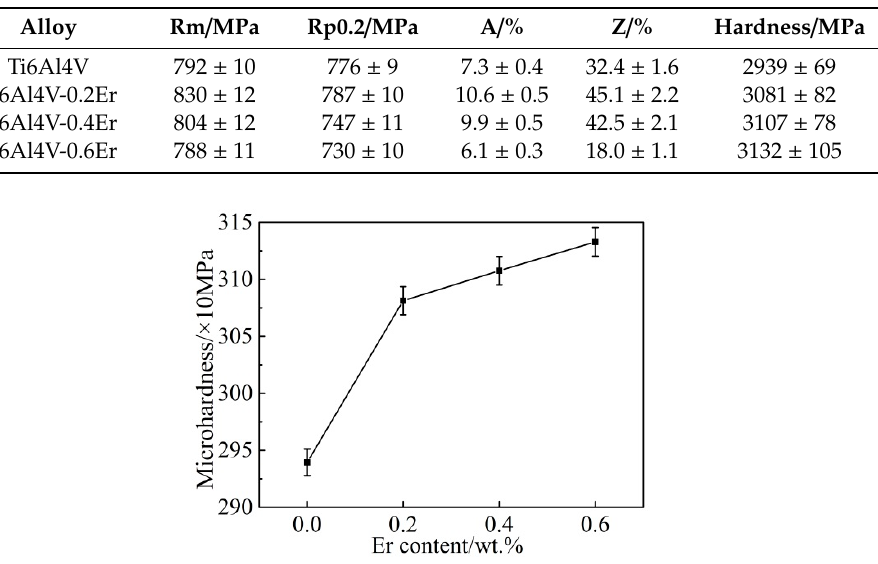
Figure 10. Vickers hardness of Ti6Al4V-xEr casting alloys.